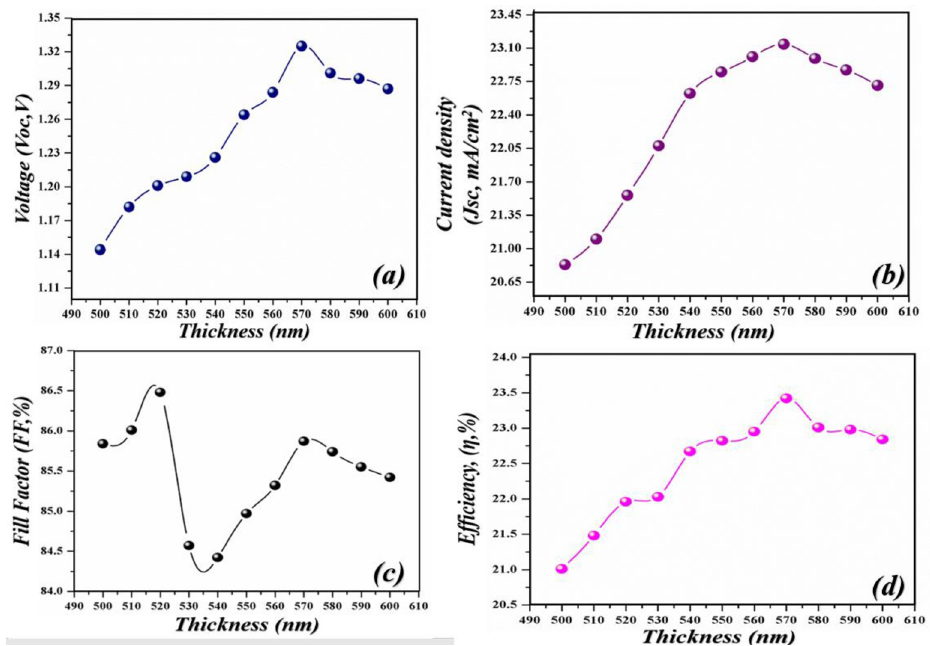
Fig 3. Simulated photovoltaic parameters of novel geometry (a) V layer, (b) J sc as an independent function of the light-harvesting layer (c) FF as an independent function of light- harvesting layer (d) PCE as an independent function of light-harvesting layer.